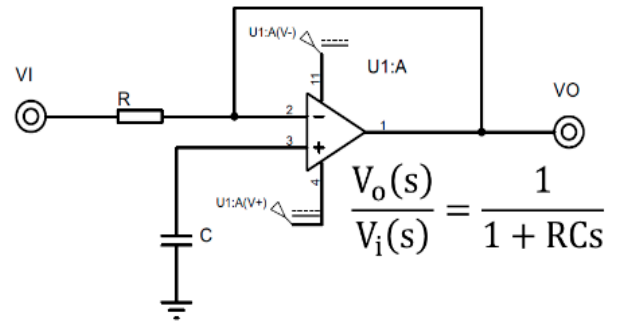
Figure 7. First order low pass filter and its transfer function as a function of the complex variable 𝑠 .